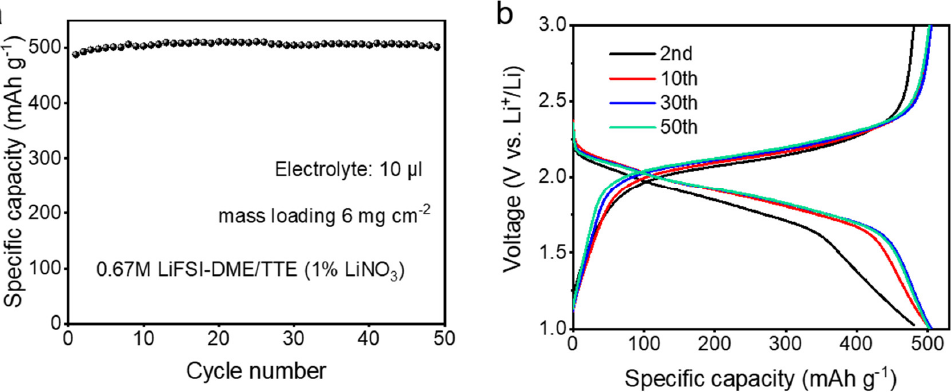
Figure 3. ( a ) Cycling stability; ( b ) Galvanostatic current charge–discharge curves of high mass load- ing and lean electrolyte Li||pPAN/SeS 2 half−cells. and lean electrolyte Li||pPAN/SeS − 2 half